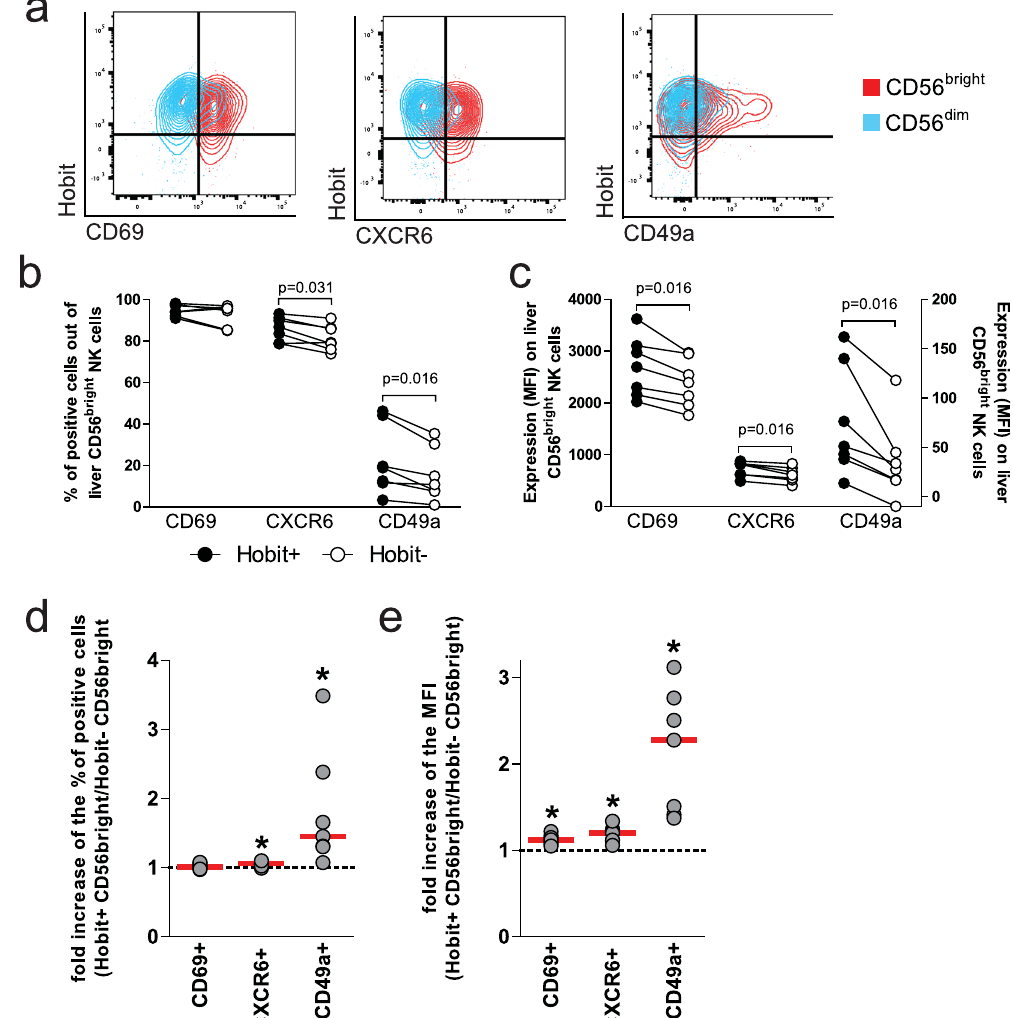
Figure 3. Hobit pos CD56 bright liver NK cells express high levels of markers related to tissue residency. ( a ) Contour plots showing expression CD69 (left plot), CXCR6 (middle plot) and CD49a (right plot) compared to Hobit on CD56 bright (red) and CD56 dim (blue) NK cells in the liver. Frequency ( b ) and expression levels ( c ) of CD69, CXCR6 and CD49a comparing Hobit pos (full symbols) to Hobit neg (open symbols) CD56 bright NK cells from the liver. ( d ) Fold change (left panel) of CD69-, CXCR6- and CD49a-positive CD56 bright liver NK cells comparing Hobit pos to Hobit neg cells. ( e ) Fold increase of the MFI (right panel) of CD69, CXCR6 and CD49a on CD56 bright liver NK cells comparing Hobit pos with Hobit neg cells. Wilcoxon matched pair sign rank test was used to determine statistical differences in the scatter